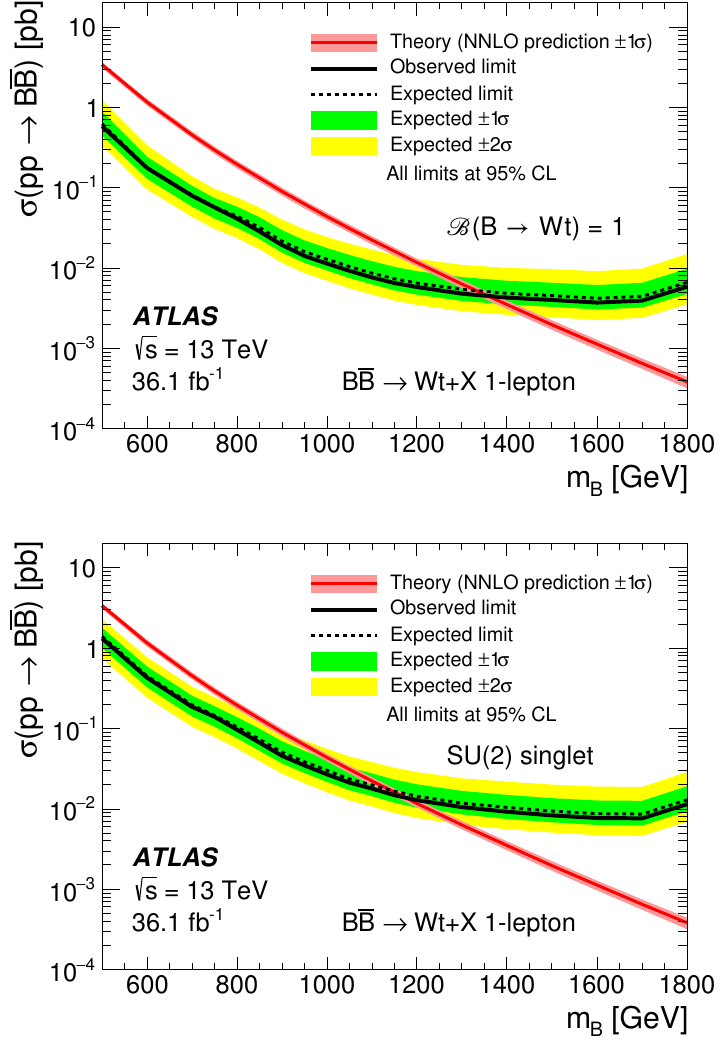
Figure 4 . Observed (solid line) and expected (dashed line) 95% CL upper limits on the B (cid:22) B cross-section as a function of B quark mass assuming singlet B scenario (bottom). The surrounding shaded bands correspond to deviations around the expected limit. The red line and band show the theoretical prediction and its 1 standard deviation (cid:6)